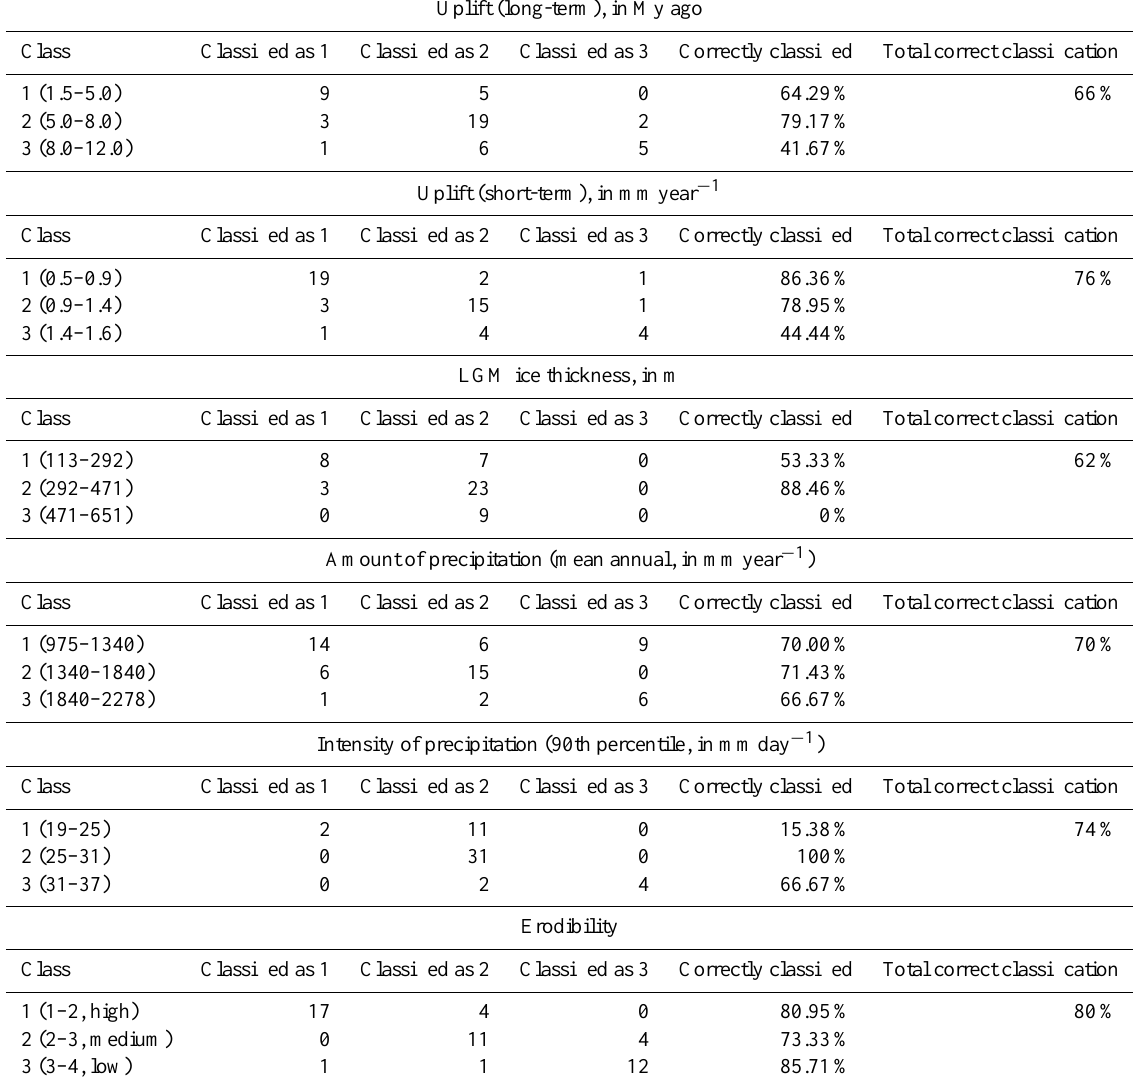
Table 3. Results of the LDA classification based on the topographic variables for each of the controlling variables.